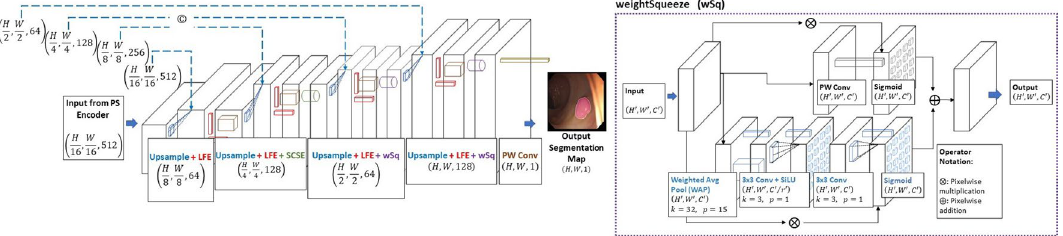
Figure 4. Details of the proposed PS decoder and wSq